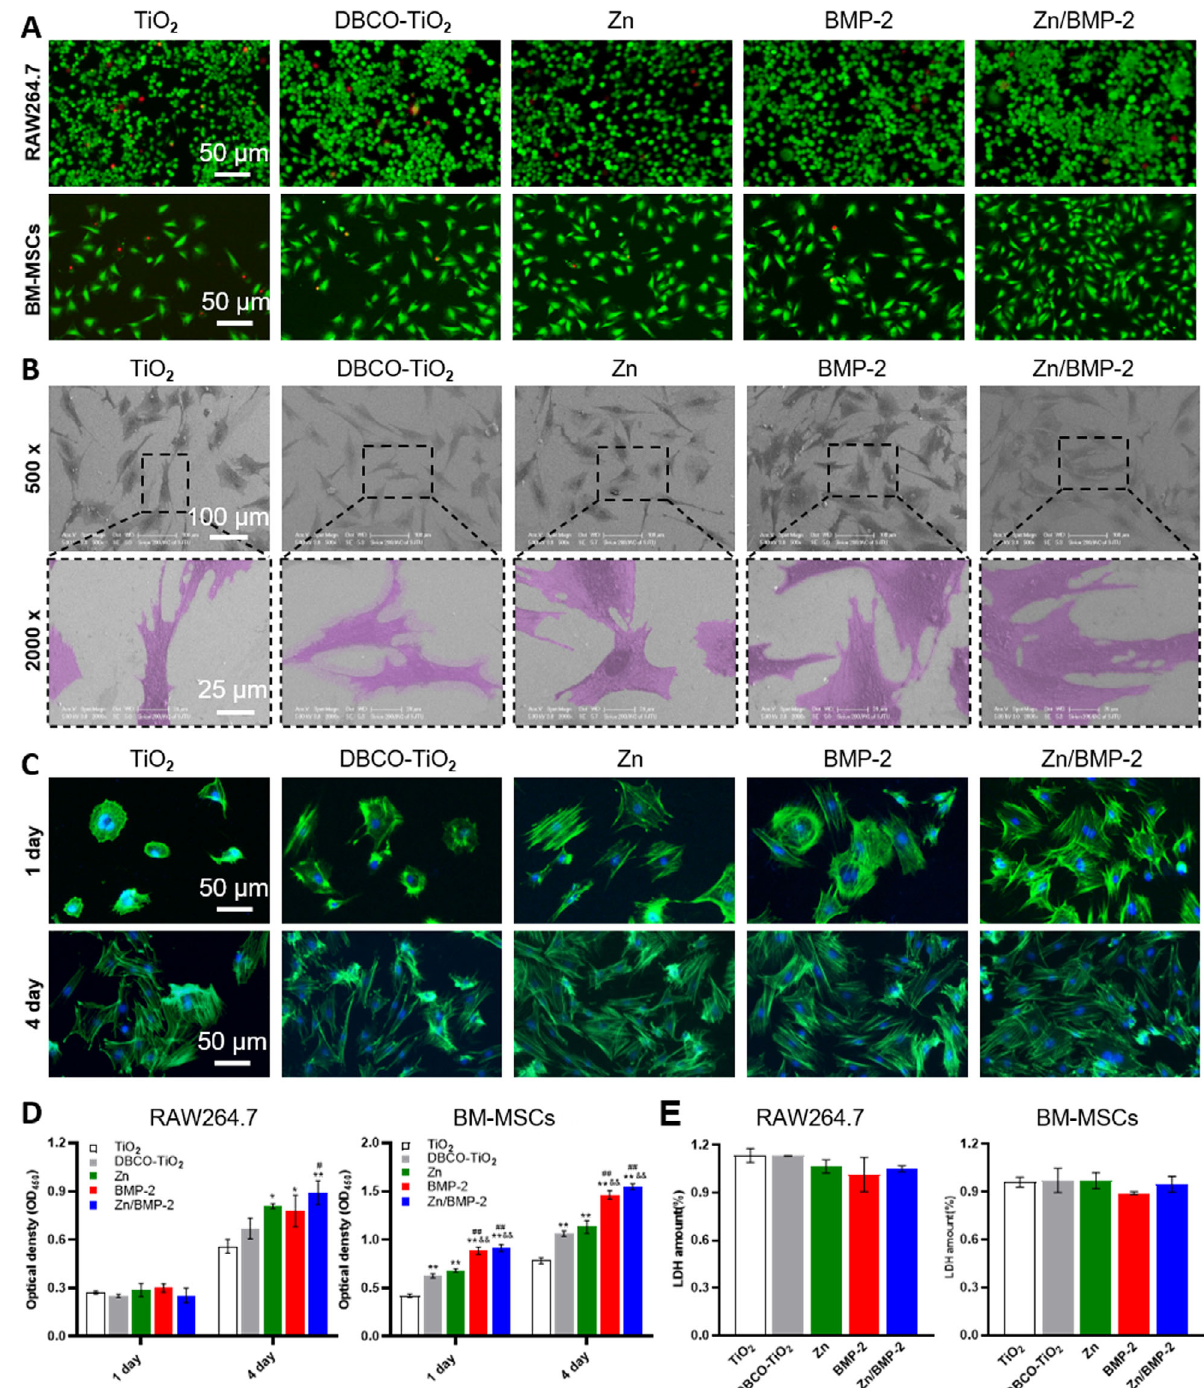
Fig. 3 Biocompatibility properties of Zn 2 + and BMP-2 co-modi fi ed TiO 2 surfaces. A Live/Dead staining of BM-MSCs and RAW264.7 on the bare and modi fi ed TiO 2 surface (DBCO-TiO 2 , Zn, BMP-2 and Zn/BMP-2) (scar bar = 50 μ m, three independent experiments). B Scanning electron images of BM- MSCs on different surfaces (×500 scar bar = 100 μ m and ×2000 scar bar = 25 μ m, three independent experiments). C The cytoskeleton staining (FITC- phalloidin/DAPI) of BM-MSCs on different surfaces for 1 and 4 days (scar bar = 50 μ m, three independent experiments). D Cell viability of BM-MSCs and RAW264.7 on different surfaces for 1 and 4 days (CCK-8) ( D n = 3 independent samples per group, by a one-way ANOVA with a Tukey ’ s post hoc test for multiple comparisons). E Cell cytotoxicity of BM-MSCs and RAW264.7 on different surfaces for 24 h ( E n = 3, independent samples per group, by a one- way ANOVA with a Tukey ’ s post hoc test for multiple comparisons). Data are reported as mean ± SD, * p < 0.05, ** p < 0.01 compared with the bare TiO 2 surface; # p < 0.05, ## p < 0.01 com p ared with the DBCO-TiO 2 surface; & p < 0.05, && p < 0.01 compared with Zn surface. Exact P values were given in the Source Data fi